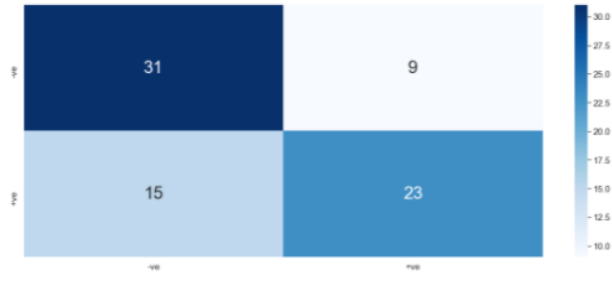
Figure 25. Performance of Decision